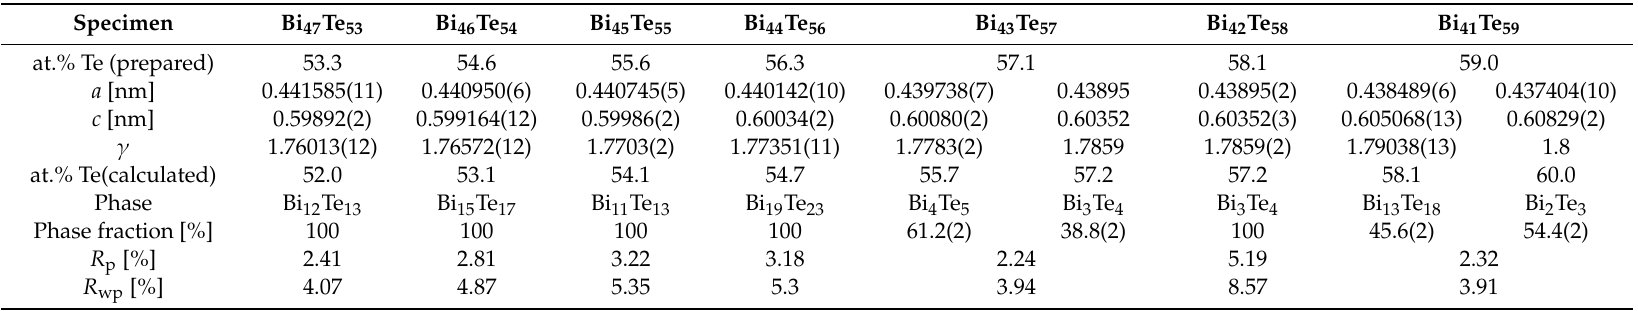
Table 2. Refined lattice parameters and final R factors for Bi–Te. The di ff raction data used for the analysis were acquired in the 2 θ range of 1.8 ◦ to 50.0 ◦